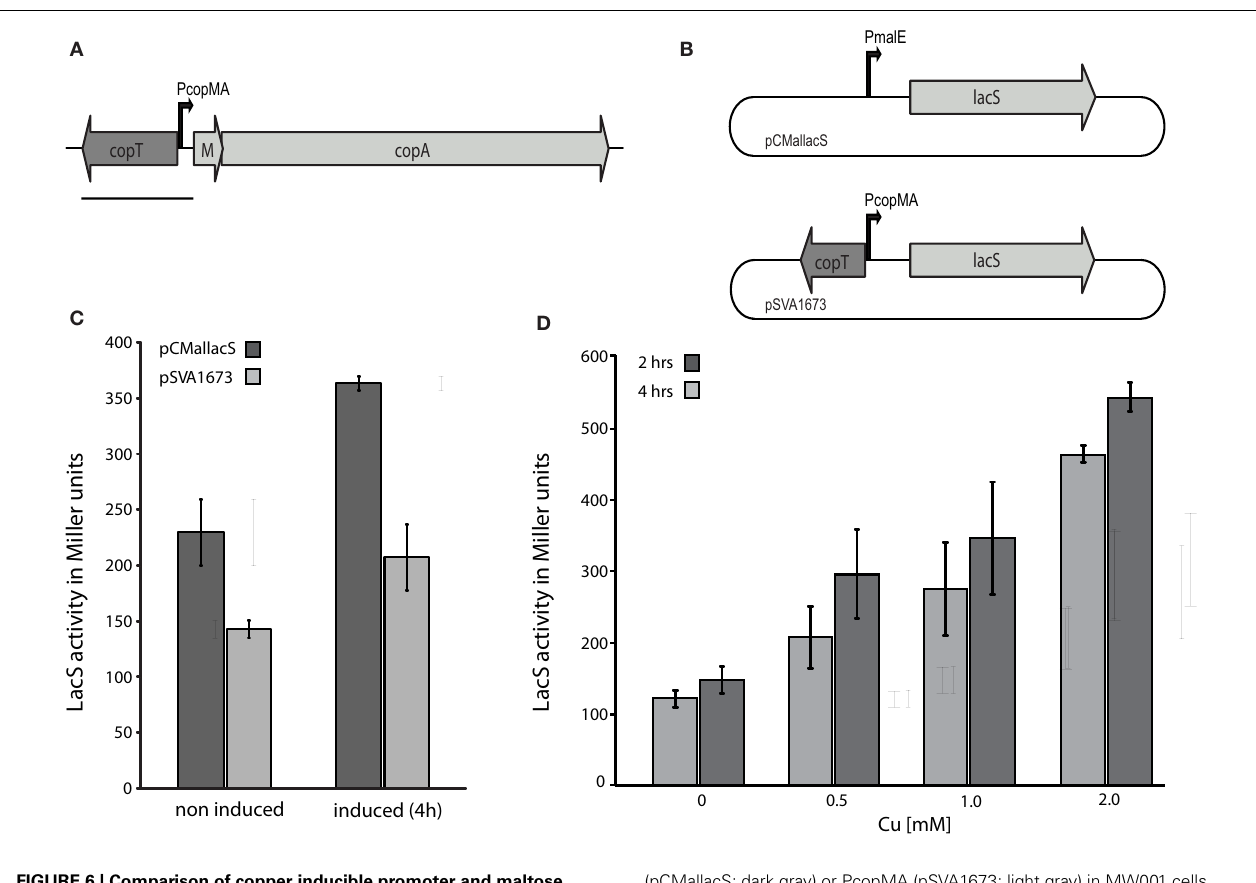
FIGURE 6 | Comparison of copper inducible promoter and maltose inducible promoter for expression in MW001. (A) Operon structure of the copper resistance cluster of S. acidocaldarius . Black line indicates the part of the operon that was included into pSVA1673. (B) Schematic representation of the plasmids pCMallacS and pSVA1673 used in (C,D) . (C) Direct comparison of LacS expression under control of Pmal